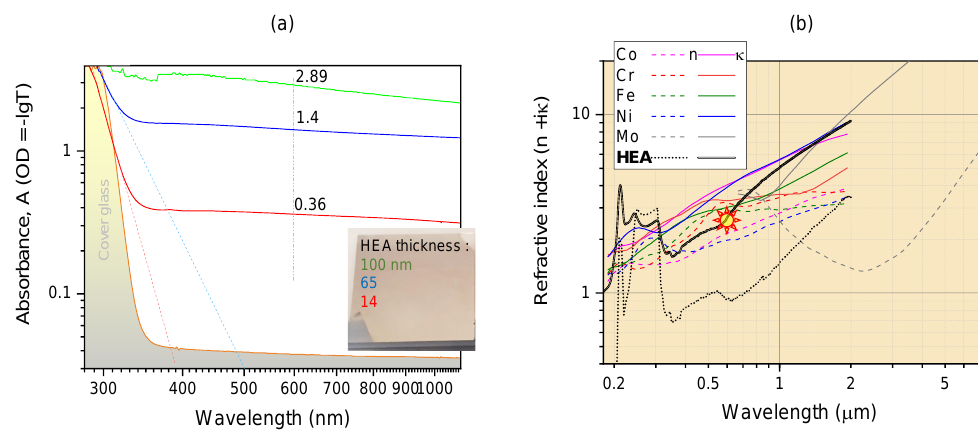
Figure 2. ( a ) Absorption spectra of CoCrFeNiMo 0.2 films of different thickness; cover glass absorption (shaded profile) was compensated by using reference (Shimadzu). ( b ) Real and imaginary parts of the refractive index ( n + i κ ) of the constituent metals and HEA. Marker shows the point of κ = 2.685 at λ = 600 nm of the CoCrFeNiMo 0.2 HEA; absorption coefficient α = 4 πκ / λ ≈ 6 × 10 5 cm − 1 is obtained from the Beer–Lambert